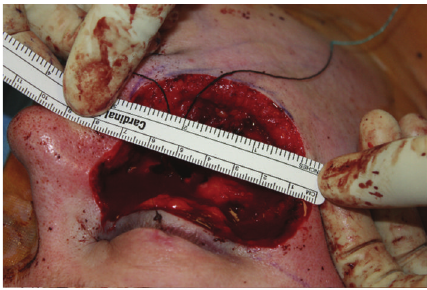
Figure 1: Case 3, 7 × 17cm right-sided facial skin and maxillectomy defect after resection of right-sided squamous cell carcinoma.